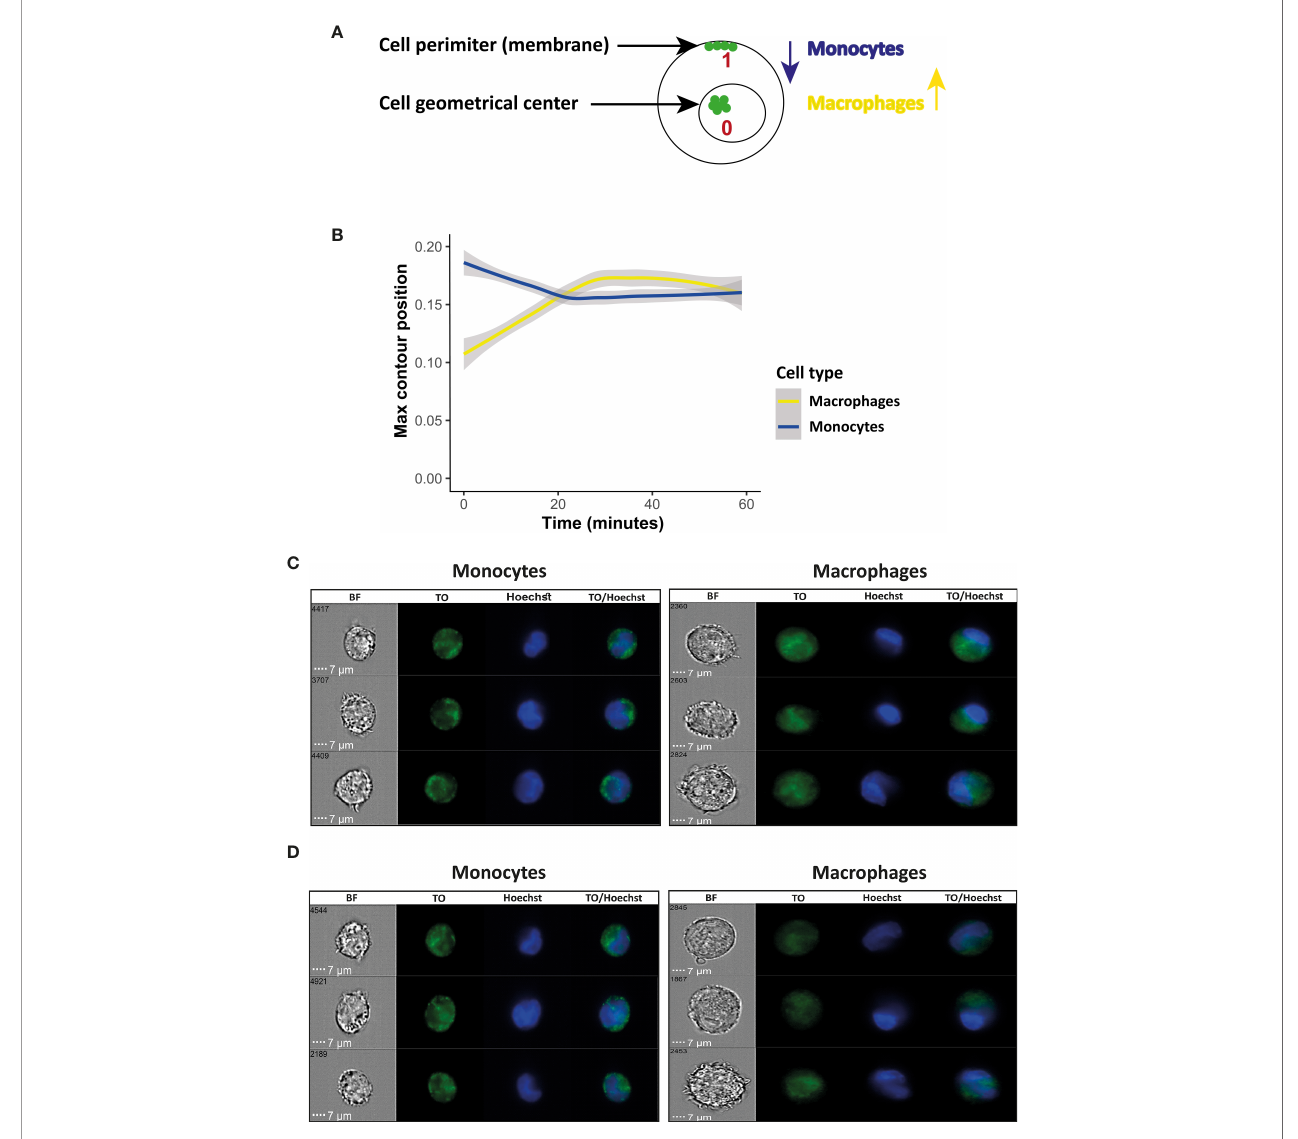
FIGURE 4 | Kinetic measurement of fl uorescent signal associated with RNA cargo using Max Contour Position inside recipient monocytes or macrophages. Pf -derived EVs were labeled by Thiazole orange (TO), and their uptake into monocytes (THP-1) cells and macrophages was measured for 1 hour. (A) Schematic representation of the Max Contour Position feature; 0 being the object center (the geometrical center of the cell) and 1 being the object perimeter (the cell membrane). (B) Graph representing the change in the subcellular location of the contour within the cell that has the highest intensity concentration, over time. Cell types were compared with a linear mixed effects model, with cell type and time as fi xed factors, and sample ID as a random factor. Statistics were done in R, v. 4.0.4, using the package ‘ lmerTest ’ . For calculating changes relative to the starting point, a log2-fold change was calculated per each point, relative to its own sample ’ s average value of the fi rst 1.5 minutes. Grey area around the lines represents 95% con fi dence intervals, p<0.001. (C) Signal detected by IFC from three representative recipient cells of monocytes and macrophages at the fi rst 10 minutes of the uptake. (D) Signal detected by IFC from three representative recipient cells of monocytes and macrophages at 1